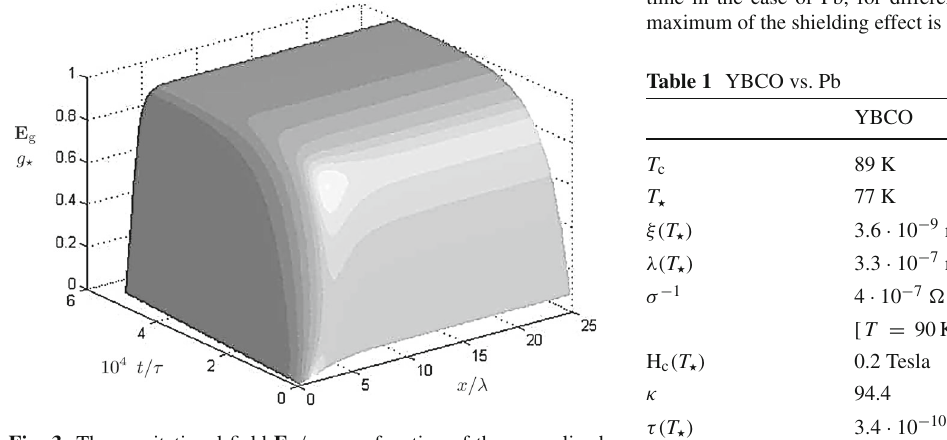
Fig. 3 The gravitational field E g / g (cid:23) as a function of the normalized time and space for Pb at T = 6 . 3K